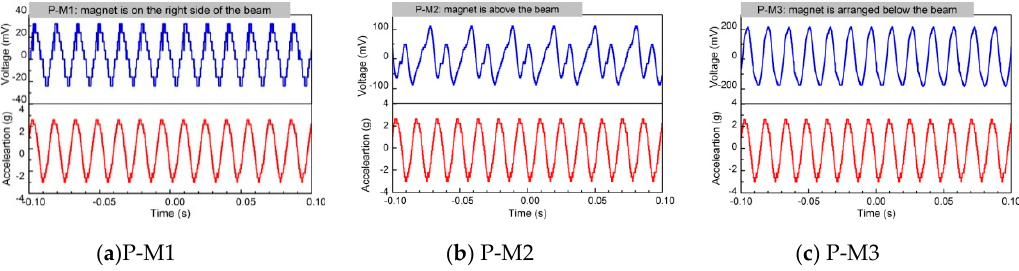
Figure 19. Open-circuit output voltage waves of the harvesting prototype with different layout of premagnetized magnet monitored by digital oscilloscope: ( a ) P-M1; ( b ) P-M2; ( c ) P-M3.